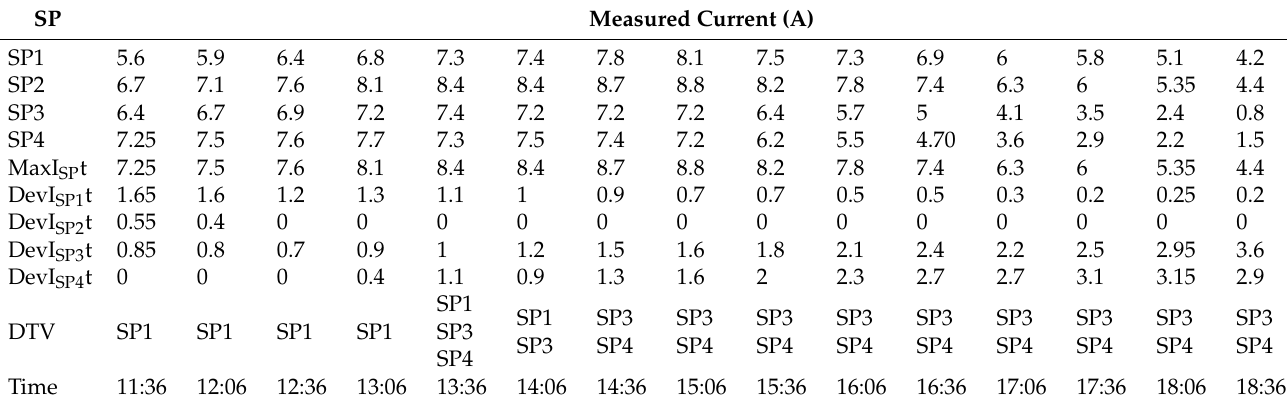
Table 3. Predictive diagnosis algorithm quantitative values.